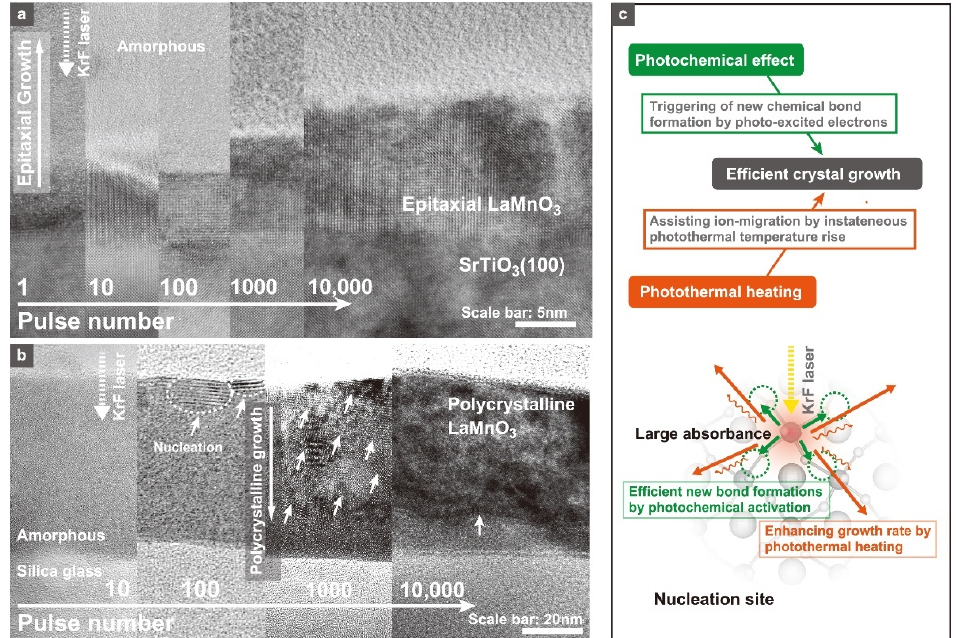
Figure 15. Cross-sectional transmittance electron microscope images for the LaMnO 3 films on ( a ) SrTiO 3 (100) [163] and ( b ) silica glass substrates during KrF laser irradiation to a LaMnO 3 amorphous matrix [164] by 10,000 pulse counts. ( c ) Proposed mechanism for the photocrystallization using pulsed UV lasers.